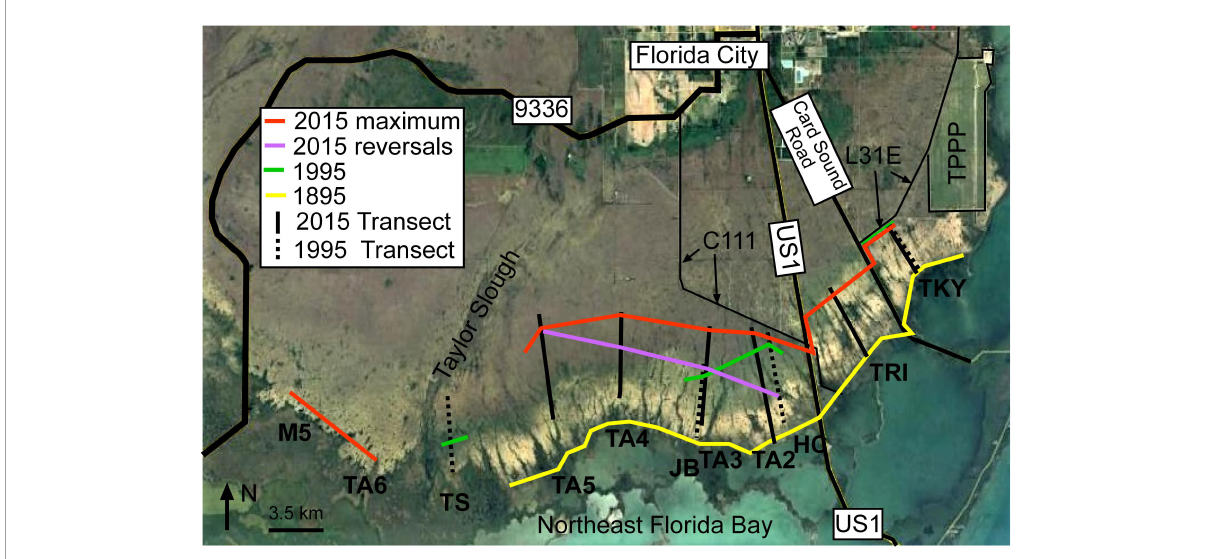
FIGURE7 Saltwater encroachment by time. Extent of saltwater encroachment in I895 (Yellow line), 1995 (Green line), 2015 maximum saltwater encroachment (Red line) and 2015 final saltwater encroachment (Purple line). The location of 1995 transects are indicated by black dashed lines and 2015 transects by solid black lines. TPPP, Turkey Point Power